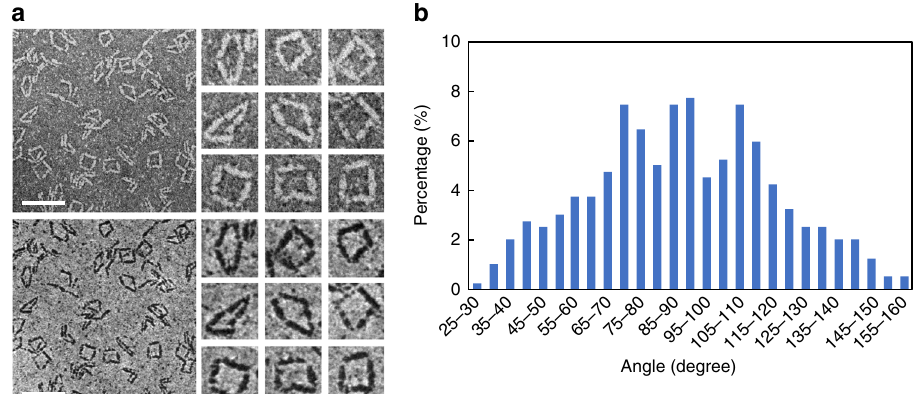
Fig. 3 Construction of protein squares and their angle distributions. a Bright- fi eld (top) and dark- fi eld (bottom) STEM images of the protein squares, with individual squares magni fi ed on the right. Scale bars, 50 nm. Magni fi ed images, 25 nm × 25 nm. b Experimental distribution of angles measured in the square nanostructures ( n = 400, with four angles measured from each of 100 squares). Source data are provided as a Source Data